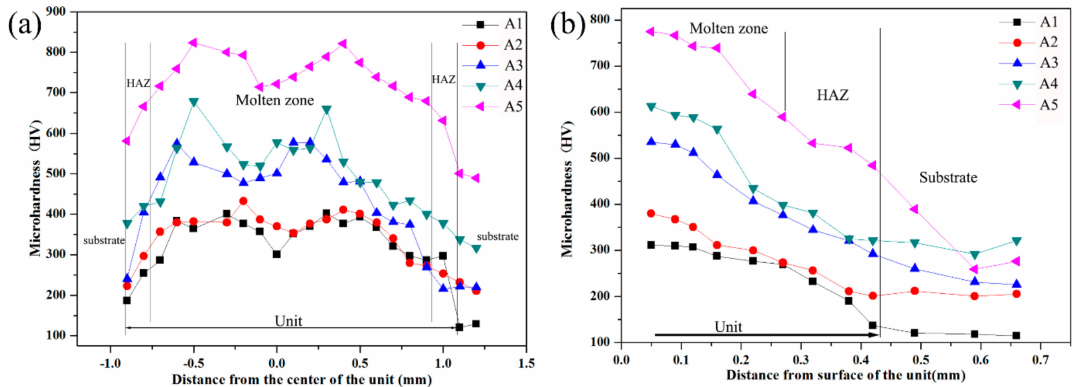
Figure 9. The hardness of the biomimetic unit: ( a ) section profile along the X -axis and ( b ) section profile along the Y